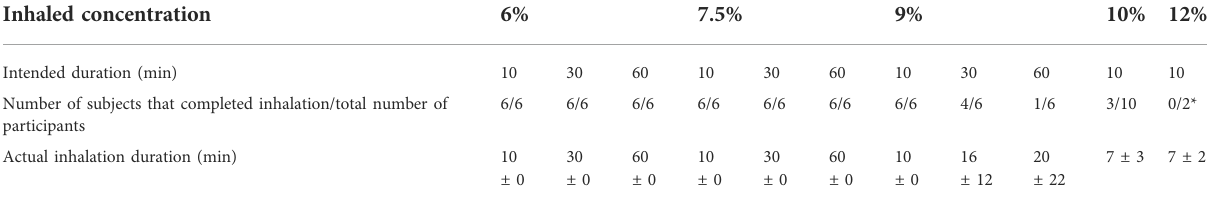
TABLE 1 Inhalation of carbon dioxide in